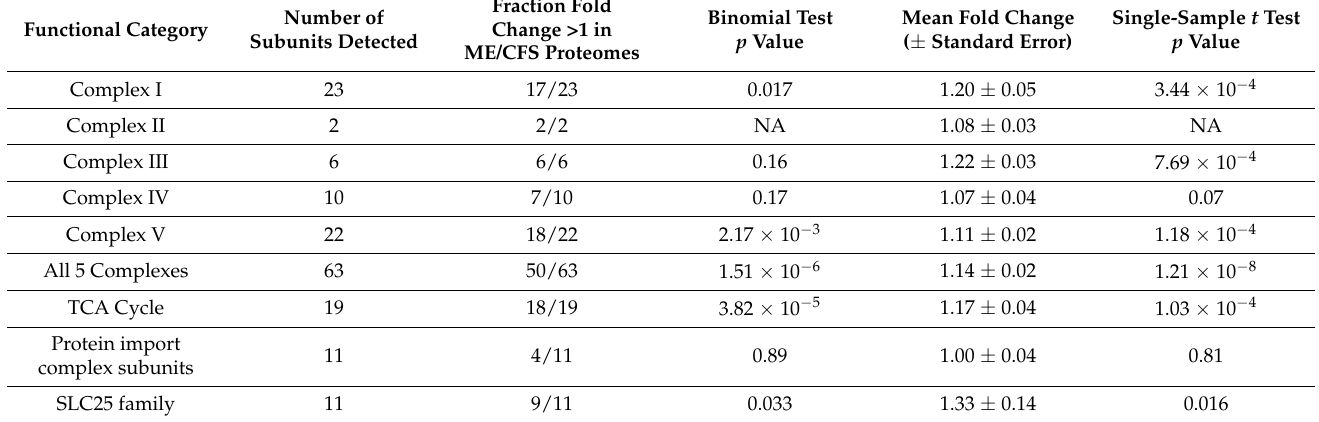
Table 2. Elevated expression of oxidative phosphorylation complex subunits, TCA cycle enzymes and SLC25 family transporters in whole-cell proteomes from Myalgic Encephalomyelitis/Chronic Fatigue Syndrome patient lymphoblasts ( n = 34) compared to healthy controls ( n = 31) was replicated from previous work. Each cell line was sampled once, or twice for a subset of healthy controls arbitrarily included to act as an internal control across each experiment in the proteomics work. Proteins detected in fewer than five samples were excluded. Fold change refers to the mean abundance of a given protein in the CFS group divided by its mean abundance in the control group, with the initial relative abundance determined by normalising Intensity-Based Absolute Quantitation abundance to the internal control average within the respective experiment. Binomial tests were employed to assess fraction upregulated with H o set to p = 0.5 (equal up- and downregulated proportions) and H 1 being that the upregulated proportion was greater. Single-sample t tests were employed to assess magnitude of upregulation with H o as mean fold change ≤ 1 and H 1 as mean fold change